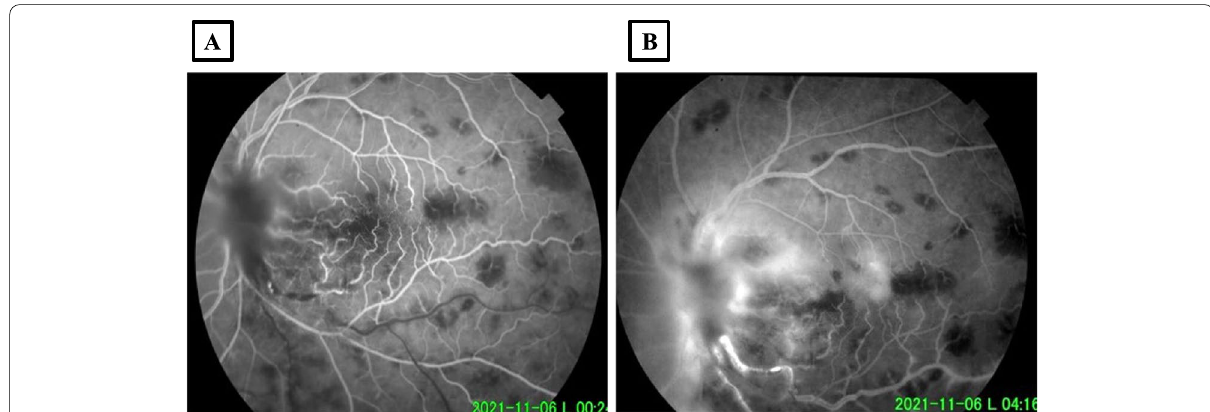
Fig. 2 Fundus fluorescein angiography: A Early phase revealing delay of filling of the infero-temporal branch retinal vein. B Late phase showing hypofluorescence of the optic disc due to the masking effect of vitreous opacity overlying the papillary area, staining of the inferotemporal vein wall as well as vascular leakage of fluorescein